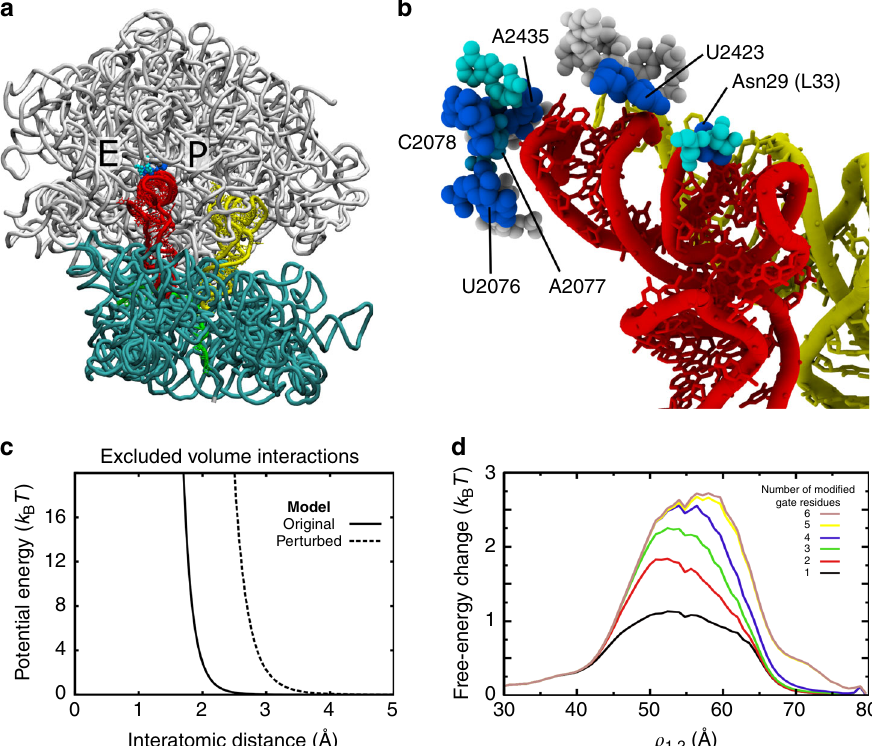
Fig. 5 A steric gate limits P/E kinetics. a Representative snapshot of the TSE associated with the I1 – I2 transition (proteins not shown). Residues that speci fi cally contact the tRNA in the TSE are shown in cyan and blue. b Close-up perspective of a TSE con fi guration, where spheres indicate which residues contact tRNA in the TSE ( p > 0.1). Blue indicates that Δ p i > 0.35: i.e. the probability of forming a contact is greater for the TSE than I1, or I2, by at least 0.35. Interactions with six residues were found to be speci fi c to the TSE: U2076, A2077, C2078, A2435, U2423, and Asn29 of protein L33. c To test whether these six residues strictly limit barrier-crossing events, we calculated perturbed free-energy pro fi les, where the excluded volume of individual residues was increased from 2.1 Å (original model) to 3.0 Å (perturbed model). Panel shows the functional form of the original and perturbed interactions. d Increase in free-energy, as a function of ρ 1,2 , when different numbers of residues ( N = 1 – 6) were perturbed. All possible combinations of gate residues were tested. For each value of N , the combination of residues that yielded the largest increase is shown. The most signi fi cant increase in barrier is found when all six residues are perturbed. However, comparable changes are found when as few as four residues are perturbed (U2076, U2423, A2435, Asn29), suggesting these residues represent the minimal constituents required to limit P/E